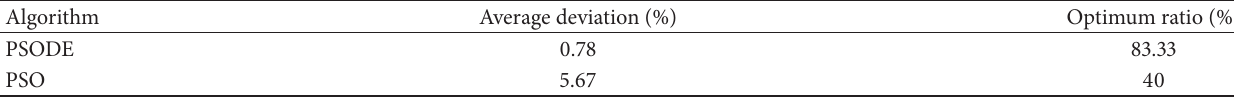
Table 2: Results comparison of PSODE algorithm and PSO algorithm.